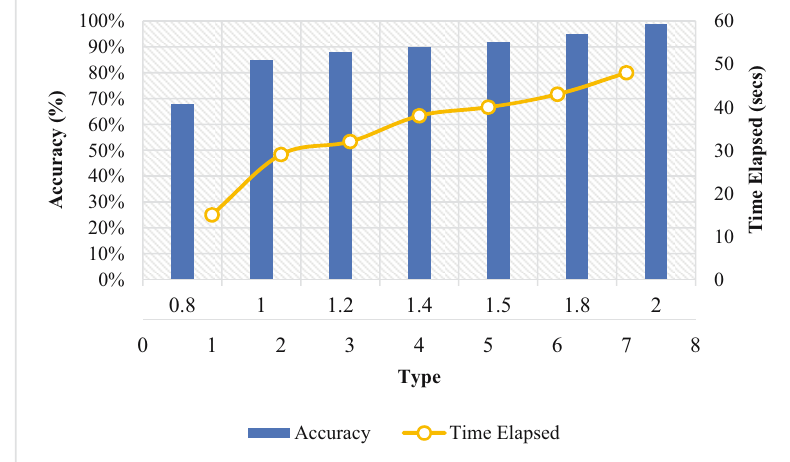
Figure 5: Test results in terms of accuracy and time